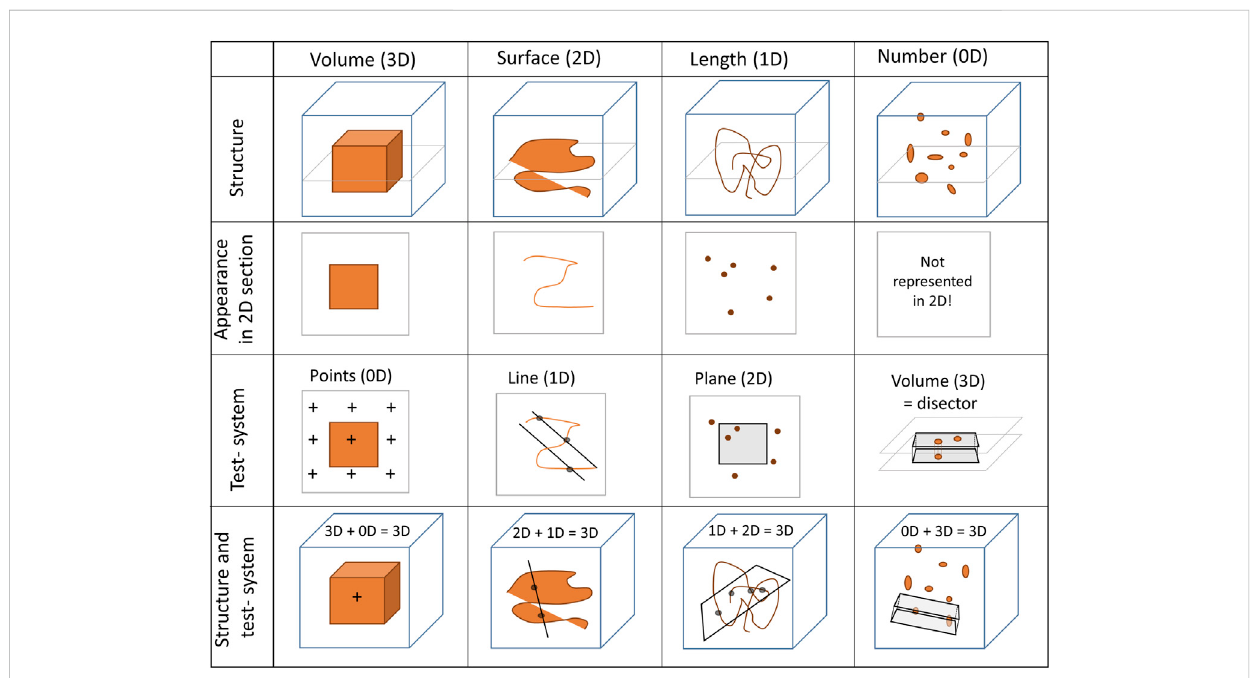
FIGURE 4 Stereological test-systems: On two-dimensional (2D) sections, three-dimensional structures (3D) lose one dimension. Accordingly, a volume appearsasanarea(2D),asurfaceareaasaline(1D)andalengthasapoint(0D).Thenumericalquantityofastructureisadimensionless(0D)parameterin three-dimensional space. Since a negative dimension is not possible this parameter is not represented on two-dimensional images. Hence, quantity of any structure cannot be determined from single sections based on the principles of stochastic geometry (or any other method) — an unbiased test- volume (3D) generated by a disector is